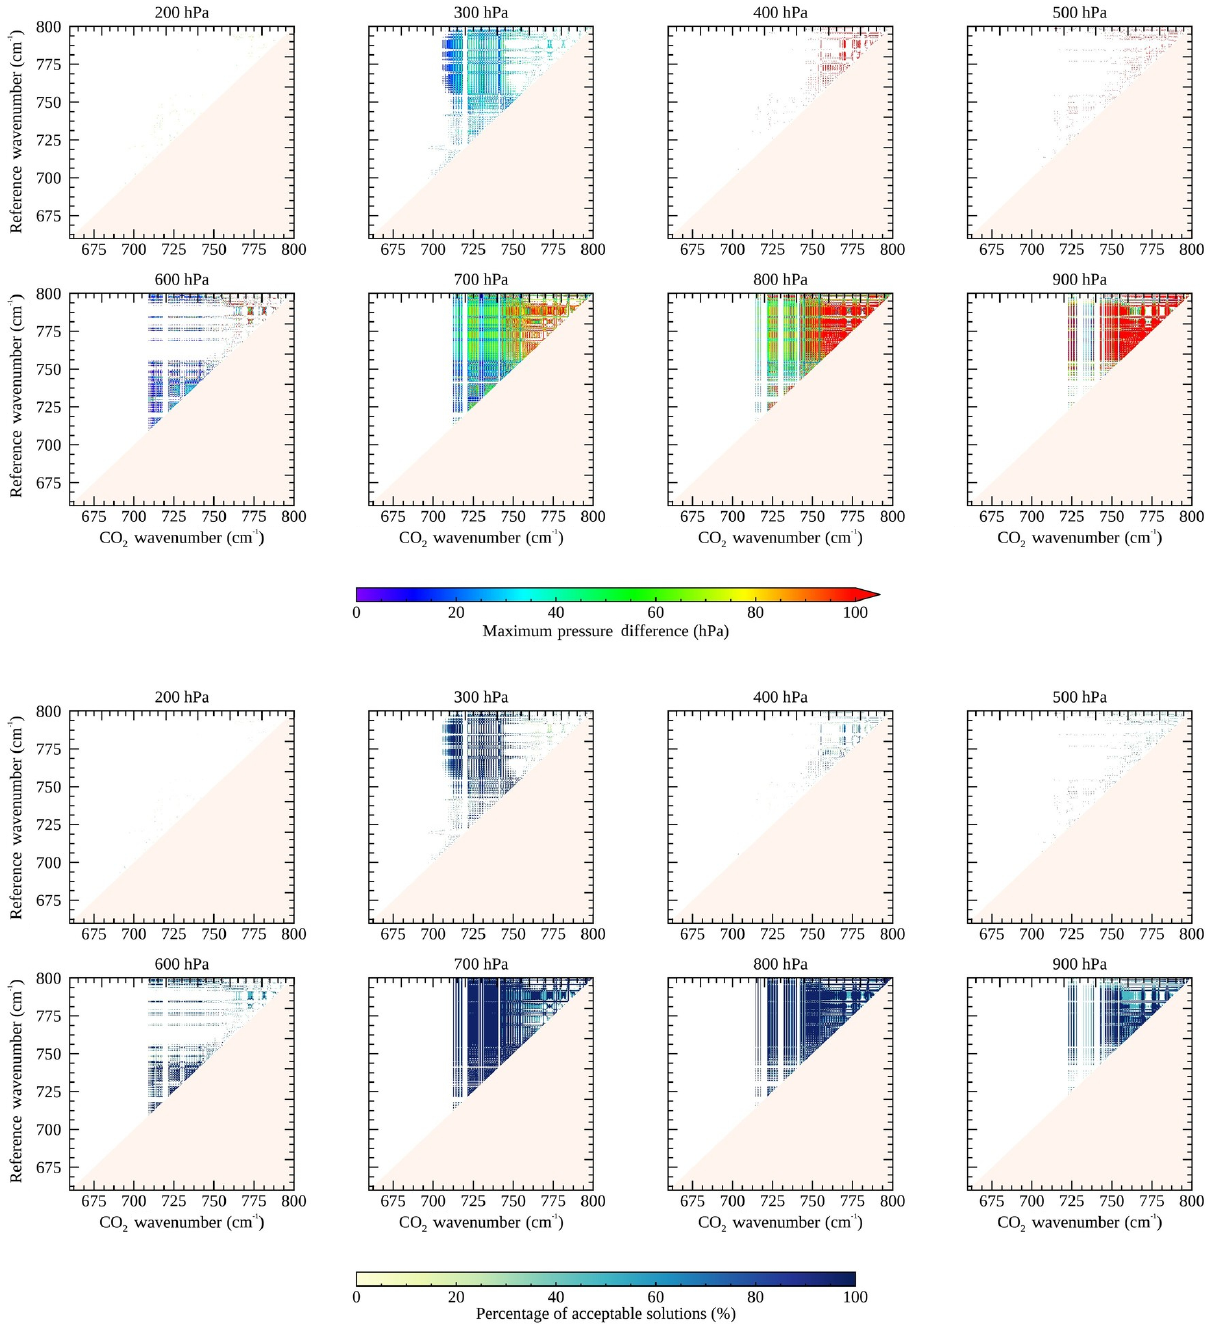
Figure A5. Same as Fig. A1 for a polar summer